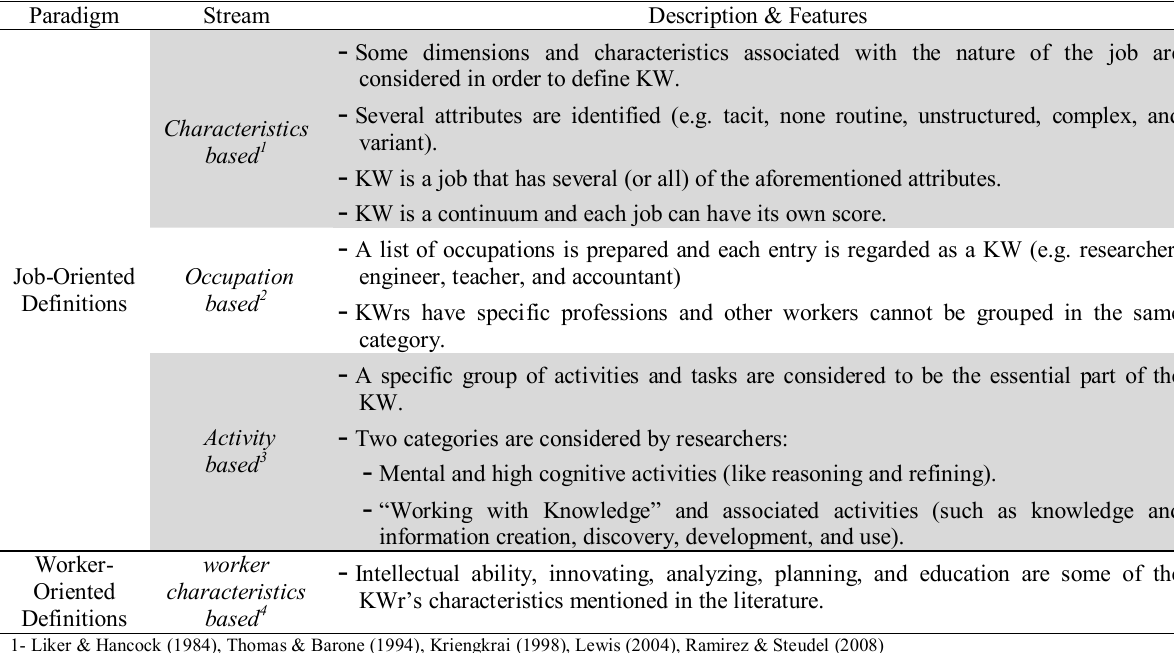
Definition Streams for Knowledge Work or knowledge worker (Heidary et al.,